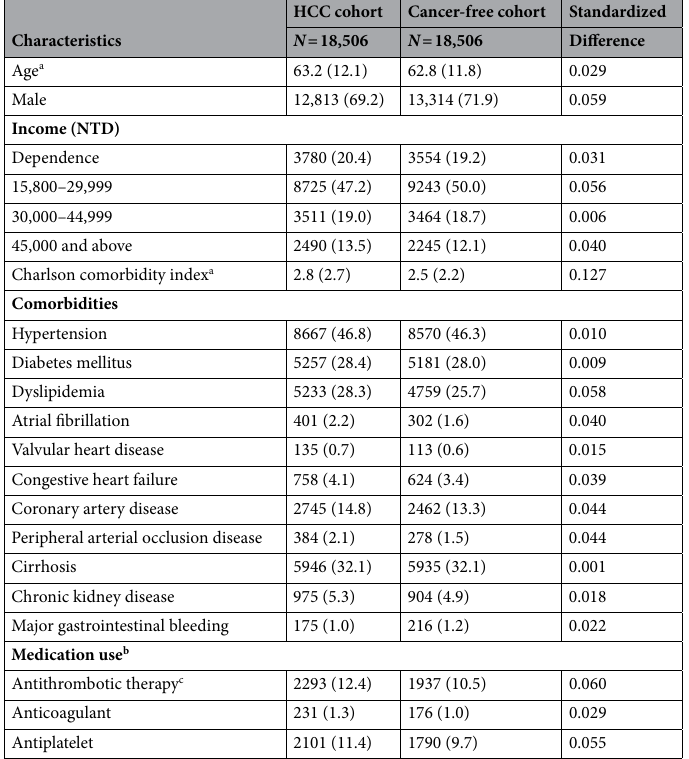
Table 1. Baseline characteristics in patients with hepatocellular carcinoma and the cancer-free cohort after propensity score matching. Data are expressed as n (%) unless otherwise indicated. NTD New Taiwan dollar, HCC hepatocellular carcinoma, SD standard deviation. a Expressed as the mean (SD). b Medication use means a drug prescription for more than 30 days during the observation period. c Antithrombotic therapy means either anticoagulant or antiplatelet